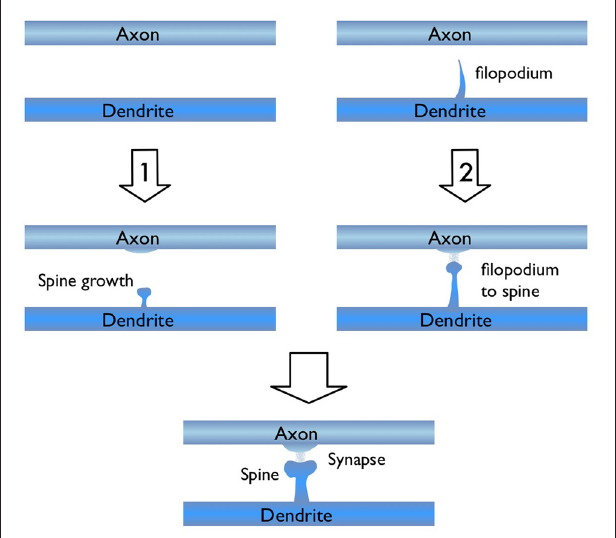
FIGURE 1 | Illustration of filopodia and spine morphologies on a dendritic branch with axonal boutons nearby. Filopodia are motile long, needle like protrusions which grow and retract within minutes. When a filopodium makes a synaptic contact, its morphology may evolve from “thin spine” to “mushroom” shape, indicating maturation.